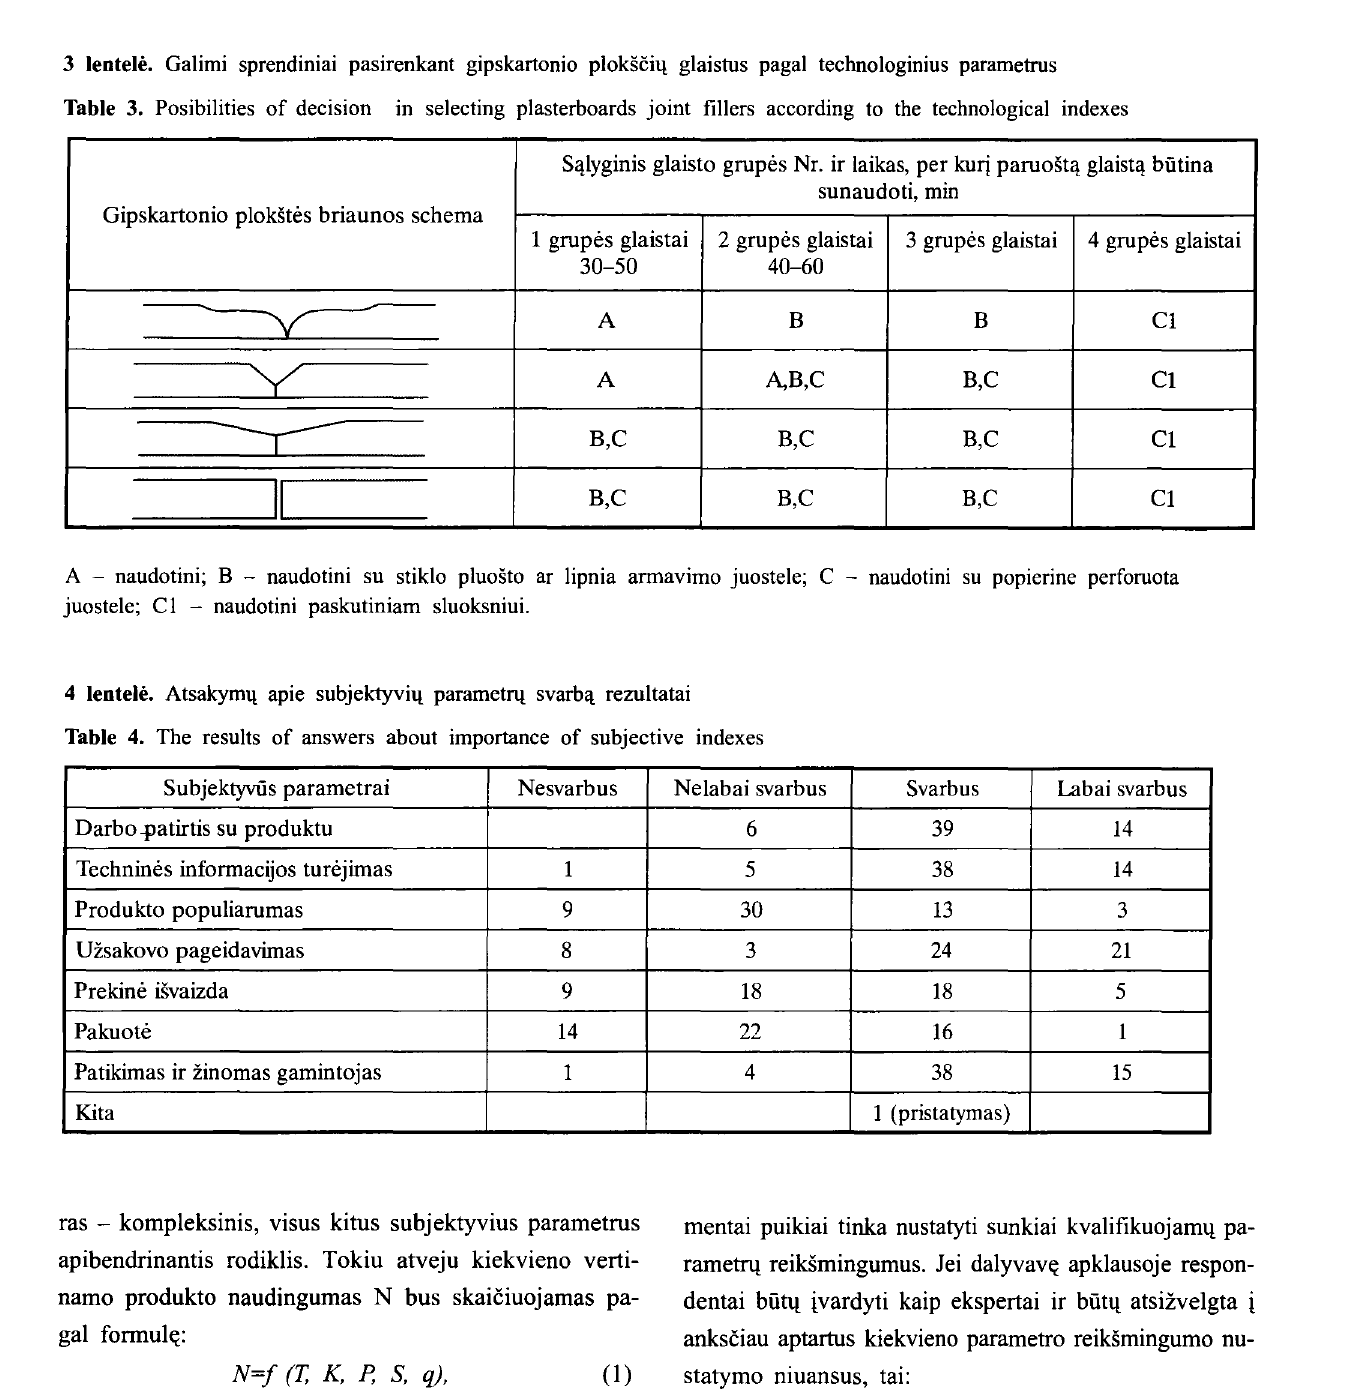
Table 3. Posibilities of decision in selecting plasterboards joint fillers according to the technological indexes